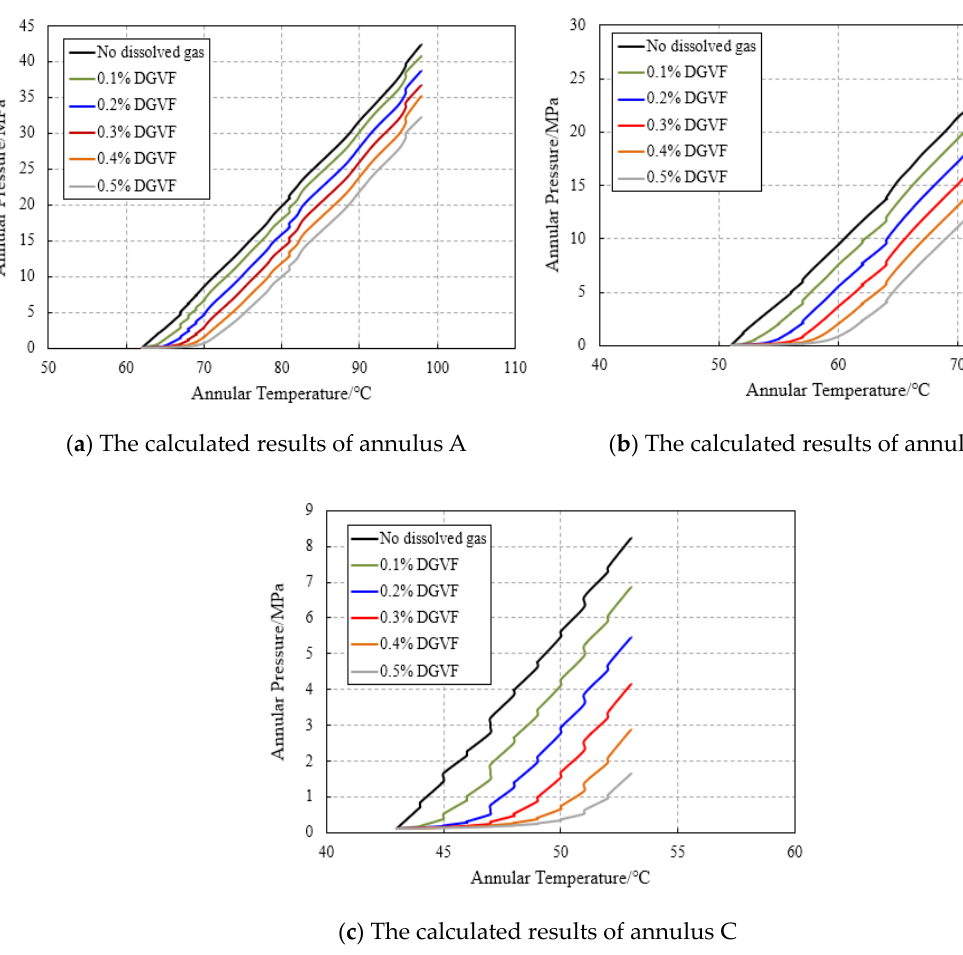
Table 7. The deviation between the results under different dissolved gas volume fraction and no dissolved gas.